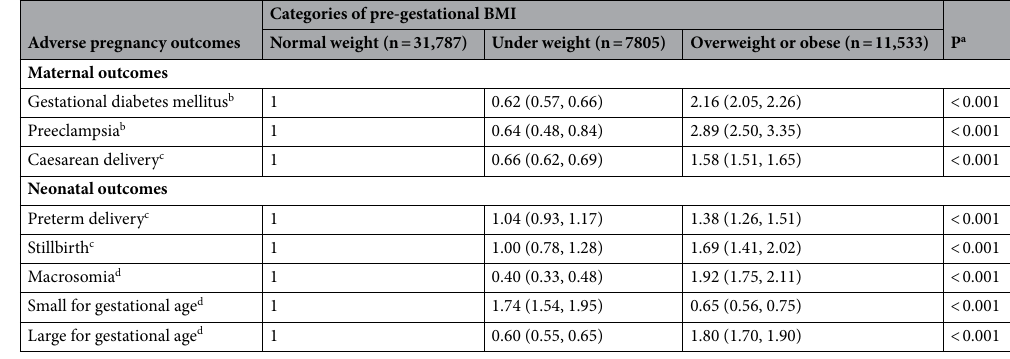
Table 3. Odds ratio for maternal and neonatal outcomes by pre-gestational BMI categories. a Data are OR with 95% confidence intervals. Normal weight group is the reference group. Logistic regression analysis was applied to calculate adjusted ORs, and Wald’s test was used. b Model adjusted for maternal age, gestational weight gain, parity, gestational age, infant’s sex, marital status. c Model adjusted for maternal age, gestational weight gain, parity, gestational age, infant’s sex, marital status, gestational diabetes mellitus, preeclampsia. d Model adjusted for maternal age, gestational weight gain, parity, gestational age, infant’s sex, marital status, gestational diabetes mellitus.